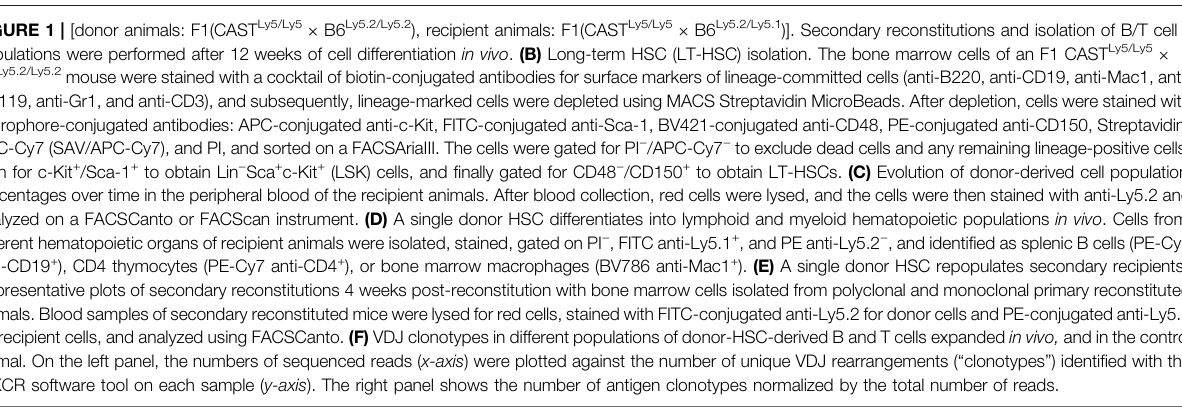
( Figure 1E ), showing that these CD150 + /CD48 − HSCs originate long-term and multilineage reconstitutions. RNA isolation and whole-transcriptome sequencing were performed for the HSC- derived B and T cell samples from the reconstituted animals. B